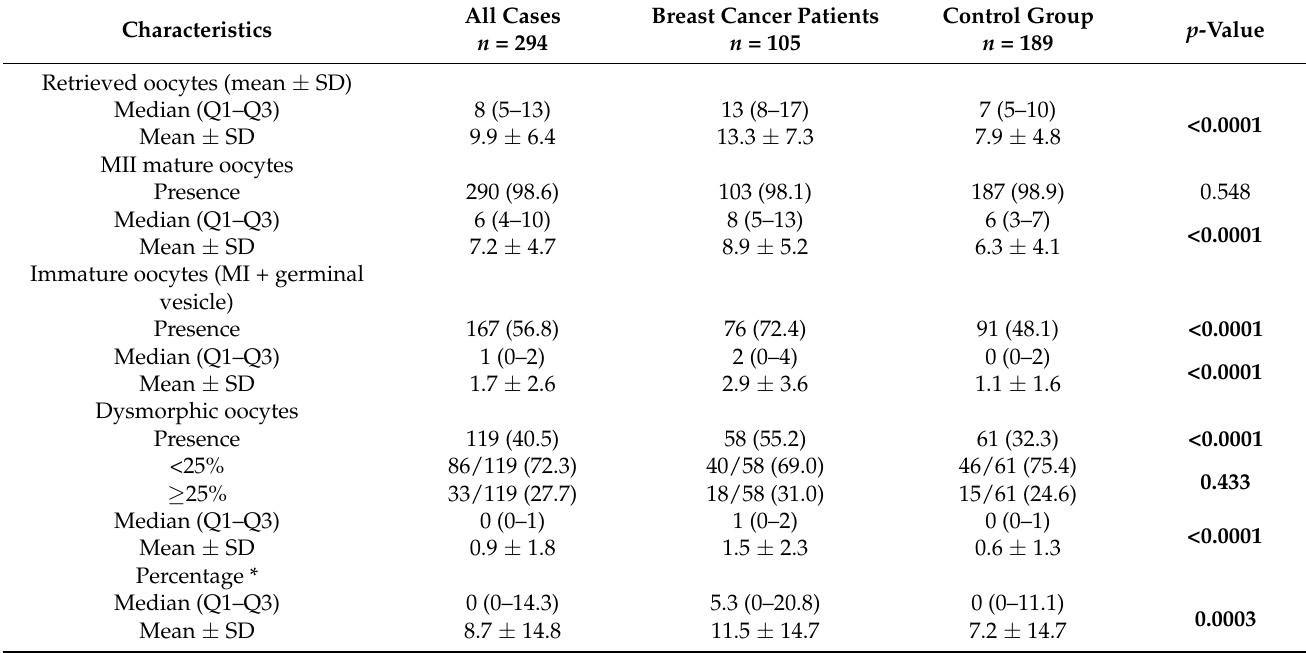
Table 3. Quality of oocytes in the study population according to the type of patient (breast cancer versus control).